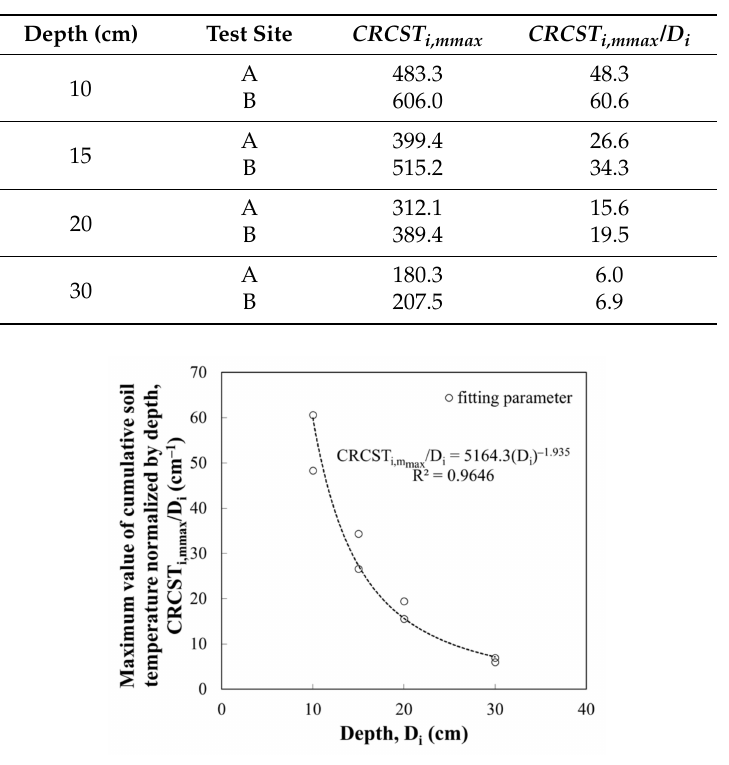
Table 2. Values of fitting parameters A and Z .